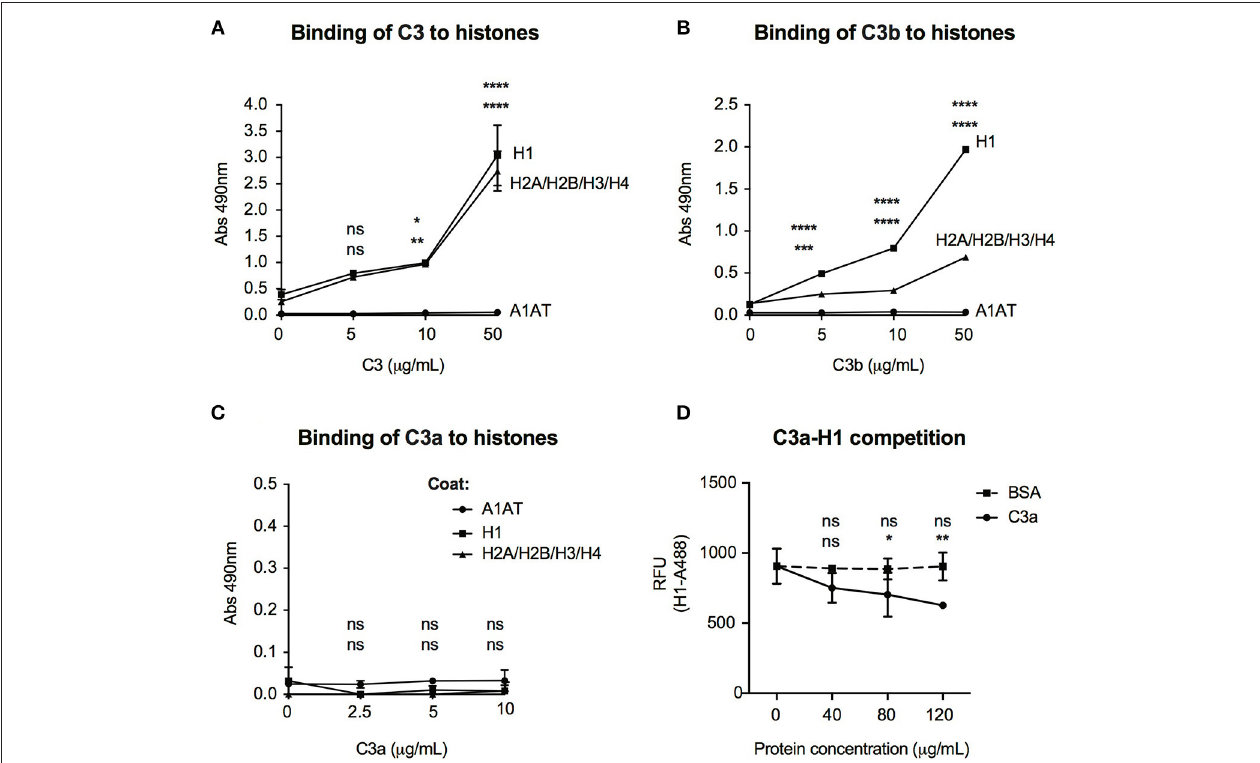
FIGURE 7 | Interaction of C3 and its cleavage fragments with histones. Recombinant histone core octamers (H2A/H2B/H3/H4), the linker H1 histone, or alpha-1-antitrypsin (negative control) were immobilized on microtiter plates and incubated with increasing concentrations of C3 (A) , C3b (B) , or C3a (C) . As negative control, BSA was used. Binding was detected either with monoclonal anti-C3d (A,B) or polyclonal anti-C3a (C) antibodies. Background signals obtained from BSA incubation were subtracted from the original values. Data are presented as mean absorbance values measured at 490nm with SD of three independent experiments. Differences with p < 0.05 were considered statistically significant and compared to 0 µ g/ml protein incubated surfaces (two-way ANOVA with Dunnett’s multiple comparison, ns p > 0.05, * p < 0.05, ** p < 0.01, *** p < 0.001, **** p < 0.0001). Upper asterisks indicate statistical significance of H1-, lower asterisks of histone octamer coated surfaces compared to binding to A1AT. (D) gDNA of Raji cells was coated on microtiter plates and AlexaFluor 488-labeled H1 histone binding was monitored in the presence or absence of C3a. As negative control, BSA was used. Background signals obtained on A1AT coated surfaces were subtracted from the original values. Data are presented as relative fluorescent unit (RFU) measured at 525nm with SD of two independent experiments. Differences with p < 0.05 were considered statistically significant and compared to no C3a treated samples (two-way ANOVA with Dunnett’s multiple comparison, ns p > 0.05, * p < 0.05, ** p < 0.01). Upper and lower asterisks indicate statistical significance of H1-AlexaFluor 488 binding in the presence of BSA or C3a (respectively) compared to binding of H1-AlexaFluor 488